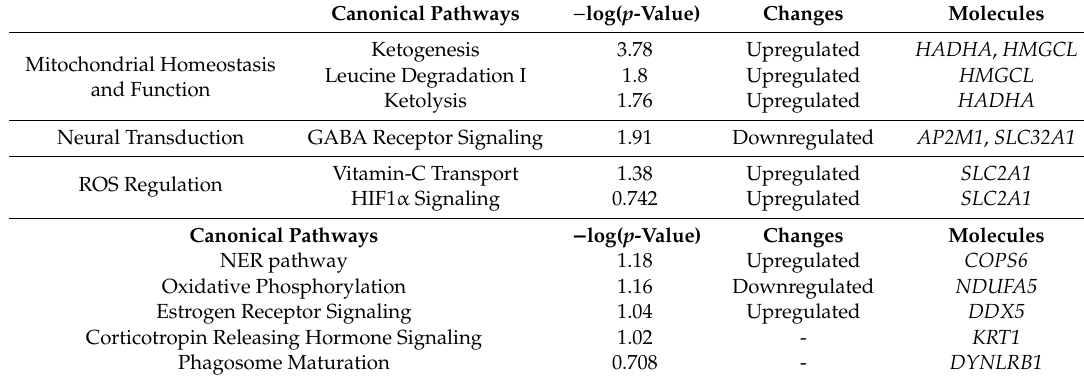
Table 5. Clustered overview of H 2 S regulated canonical pathways. ( A ) The canonical pathways restored by H 2 S. ( B ) The canonical pathways regulated by H 2 S comparing to CTRL.